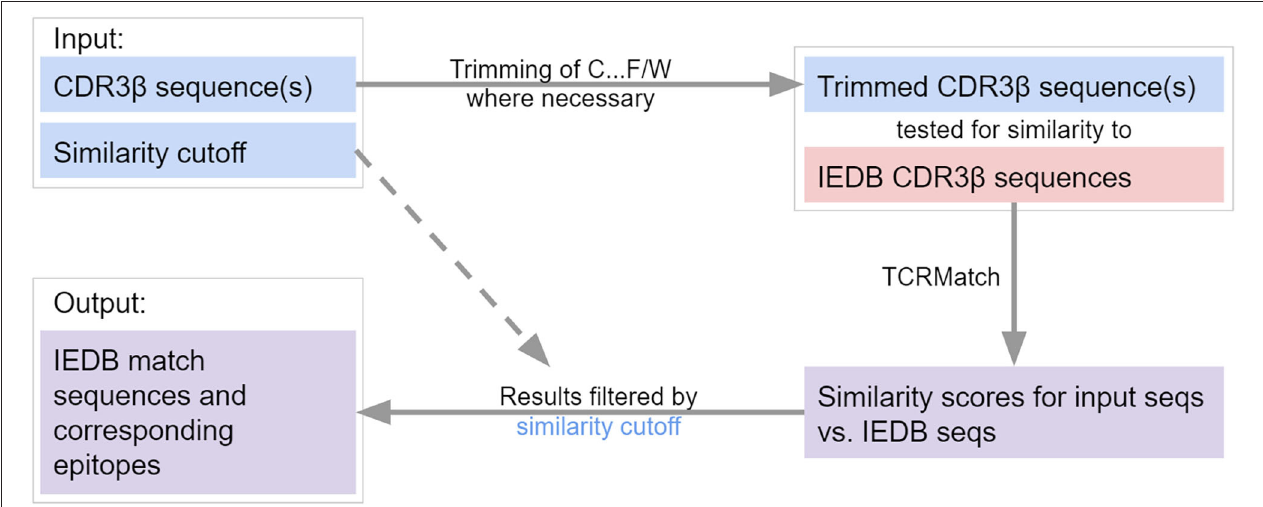
FIGURE 5 | Flowchart of TCRMatch. The user provides one or more CDR3 β sequences and selects a similarity cutoff. If N-terminal cysteine (C) and C-terminal phenylalanine (F) or tryptophan (W) are present, these residues are removed prior to the similarity search against the IEDB CDR3 β sequences. The chosen similarity cutoff is used to filter TCRMatch’s final results, which consist of matching sequences and corresponding epitopes from the IEDB.